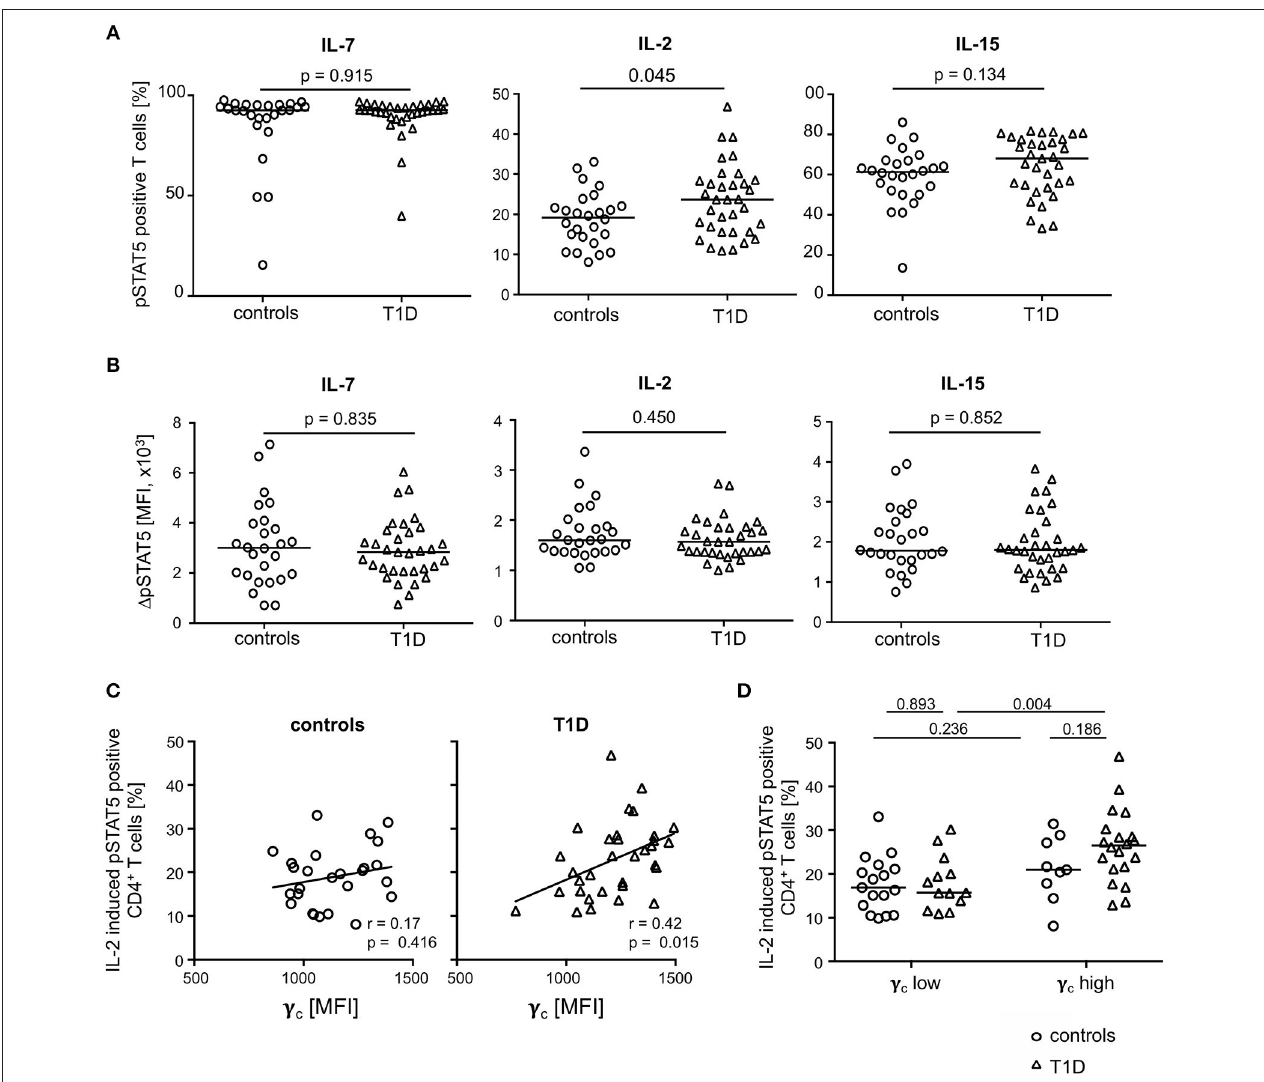
FIGURE 5 | Cytokine induced STAT5 phosphorylation in CD4 + T-cells from healthy controls and patients with T1D. Proportions of pSTAT5 positive CD4 + T-cells (A) and 1 pSTAT5 mean fluorescence intensity (MFI) of CD4 + T-cells (B) induced by IL-7 (left graph), IL-2 (middle graph) and IL-15 (right graph) are shown for healthy controls ( n = 26) and T1D patients ( n = 34). 1 pSTAT5 MFI was calculated as follows: MFI (pSTAT5 positive cells)—MFI (unstimulated cells). Every symbol represents the mean of duplicates measured for an individual donor. Median values of groups and nominal p -values for the Mann-Whitney U-test (two-tailed) are indicated. (C) Correlations between γ c expression on CD4 + T-cells and proportions of IL-2 induced pSTAT5 positive CD4 + T-cells are shown for controls (left panel) and children with T1D (right panel). Spearman rank correlation coefficients ( r ) and respective p -values are indicated. A trend line was fitted by linear regression analysis. (D) Study participants were stratified into a “ γ c low” and a “ γ c high” subgroup according to γ c expression (below or above the median γ c MFI expression) on CD4 + T-cells. Proportions of pSTAT5 positive CD4 + T-cells were compared between healthy controls and T1D and between both subgroups. Median values of groups and nominal p -values for the Mann-Whitney U-test (two-tailed) are